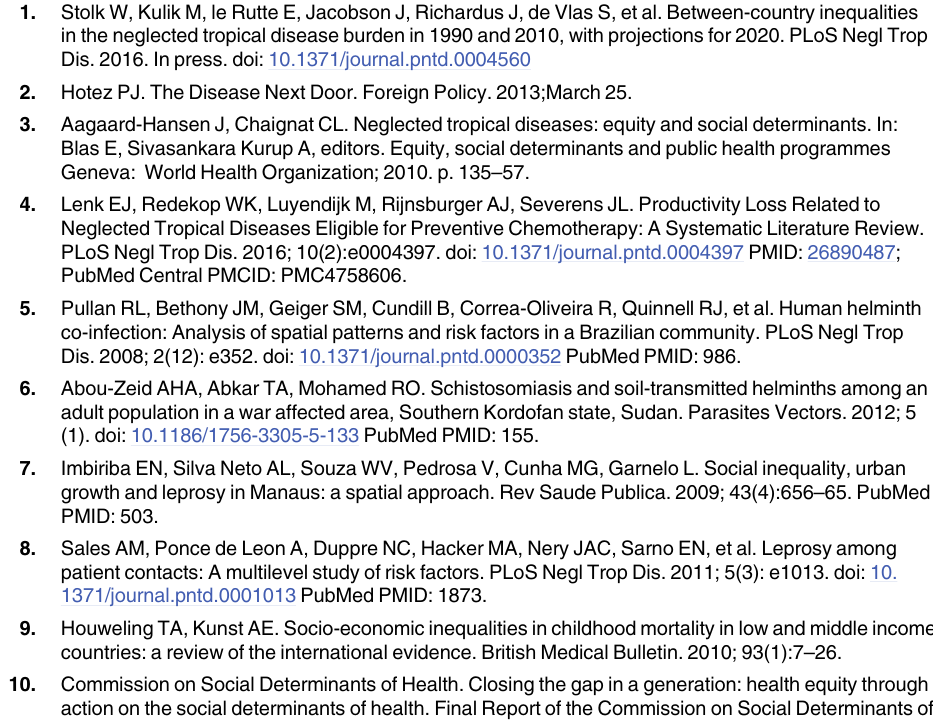
S3 Table. Summary of the literature on socioeconomic inequalities in STH, 2004 – 2013. S4 Table. Summary of the literature on socioeconomic inequalities in trachoma, 2004 – 2013. S5 Table. Summary of the literature on socioeconomic inequalities in Chagas ’ disease, 2004 – 2013. S6 Table. Summary of the literature on socioeconomic inequalities in leprosy, 2004 – 2013. S7 Table. Summary of the literature on socioeconomic inequalities in visceral leishmania- sis, 2004 –